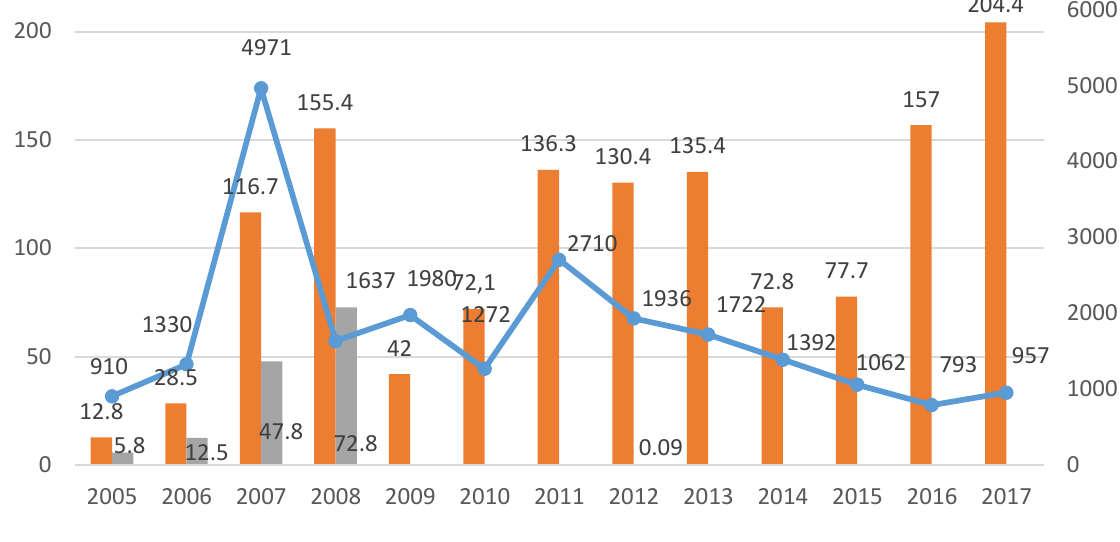
Figure 3. Main tendencies of the Ukrainian agricultural business market in the period 2005–2017